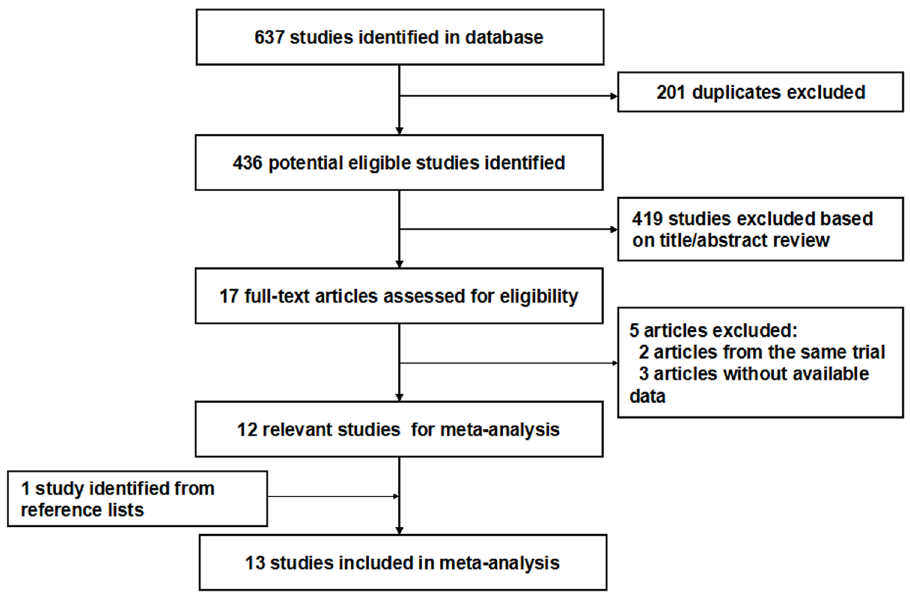
Figure 1. Flow diagram of screened, excluded, and analysed publications.